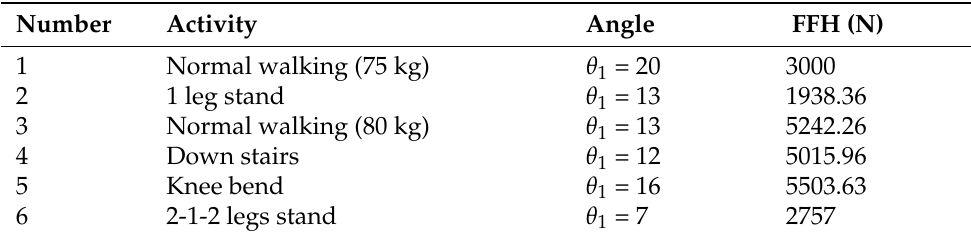
Table 3. Loads for different and daily activities. The weight of 75 kg was used for activity 1 ([2,29,46] and 80 kg for activities 2–6 [20,51]). Force on the femoral head (FFH): corresponds to the resultant reaction force (N) acting on the femoral head.